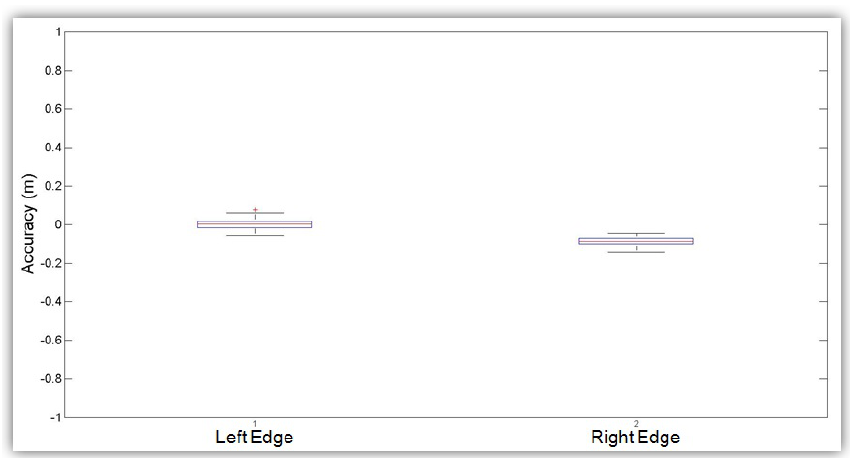
Figure 11. Box plot for the accuracy values of the extracted left and right edges in the road section.